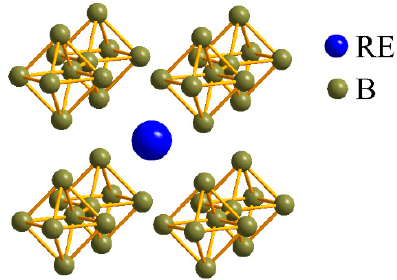
Figure 1. Typical lattice structure of rare-earth boride (REB 6 ).